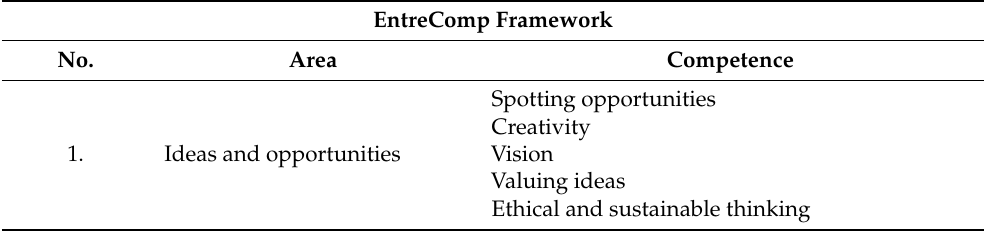
Table 1. EntreComp